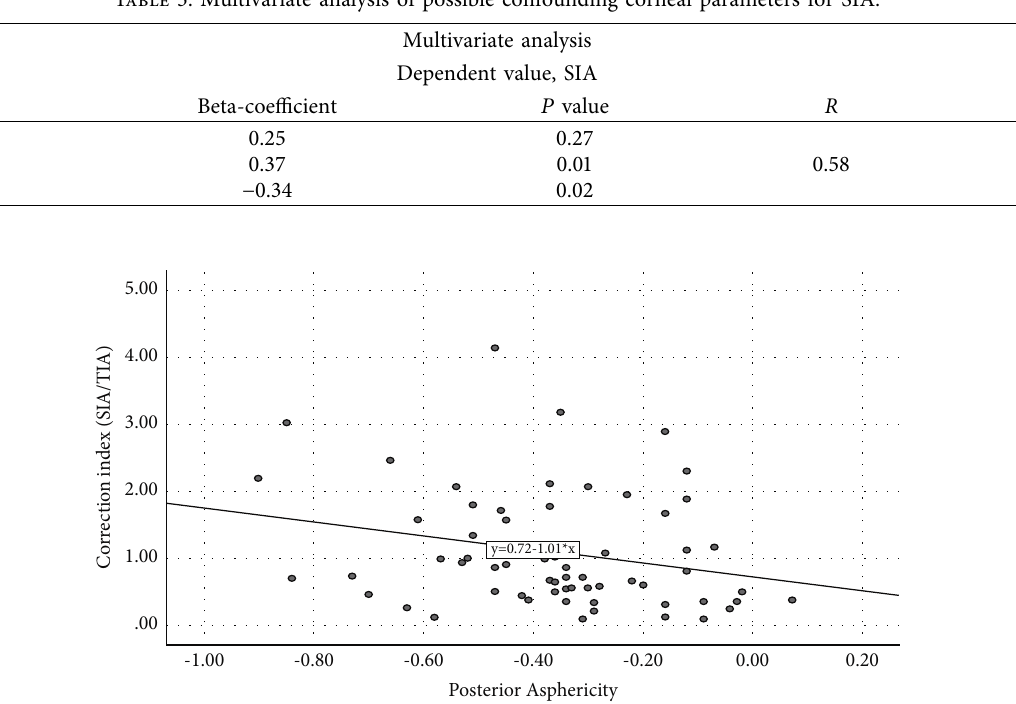
Figure 1: The correlation graph between the posterior Q value and the correlation